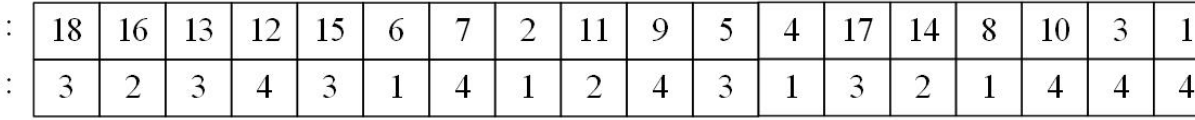
Figure 3. Example of coding for the product shown in Figure 1.